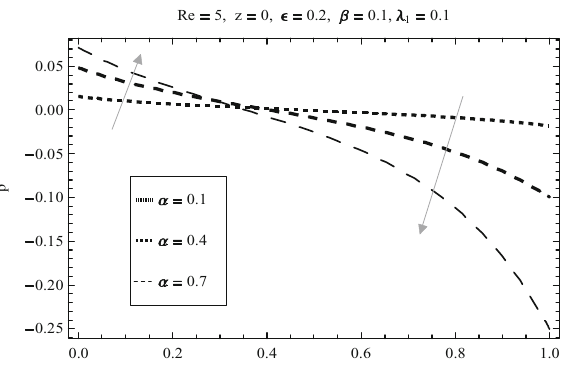
Fig. 14 Variation of p along y for different values of α